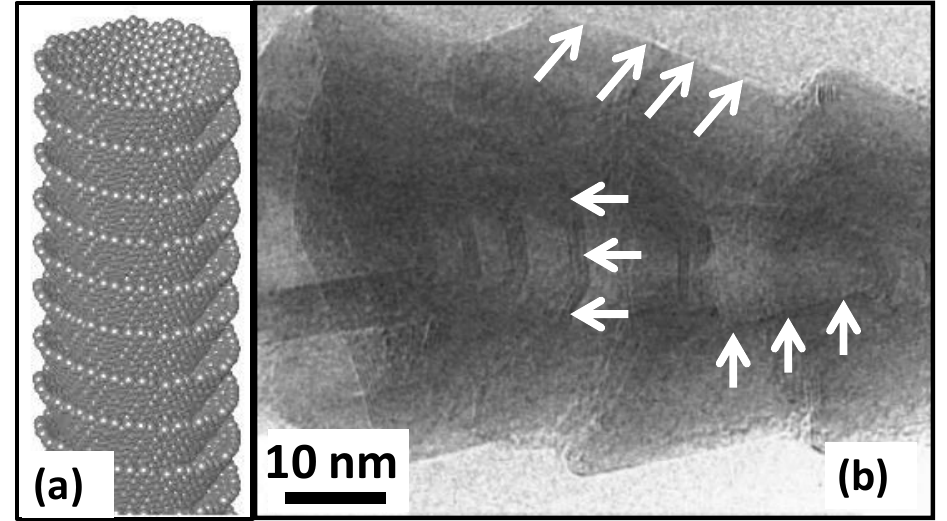
Figure 4. ( a ) An ideal representative stacked cup or cup-in-cup structure of a SCCNT and ( b ) high-resolution TEM image of coarse / irregular shaped stacked cup structure of the nanofibers used in the present study.